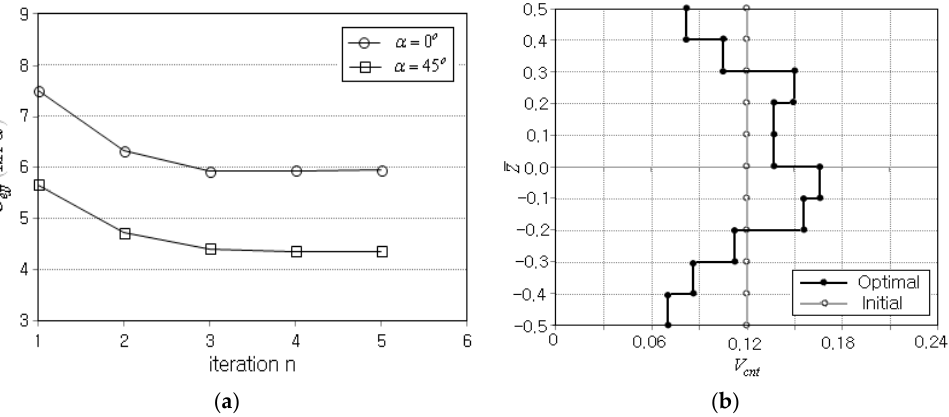
Figure 8. Comparison ( α = 45 ◦ ): ( a ) the variations in objective function, ( b ) the distributions of initial and optimum CNT volume fractions V ∗ cnt